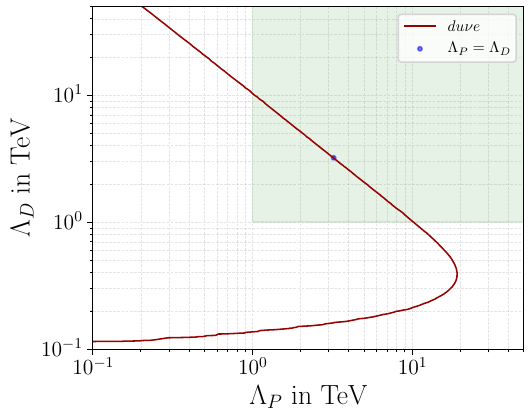
Figure 9 . Sensitivity limits for the duνe scenario for a fixed neutrino mass m N = 0 . 8 GeV . The respective Wilson coefficients are fixed to 1, allowing to show projected bounds on the new physics scales Λ and Λ responsible for production and decay of the neutrino, respectively. Further P D included are a green area marking the parameter region Λ framework is applicable, and a blue dot depicting the limit for Λ of figure 8 at 0 . 8 GeV